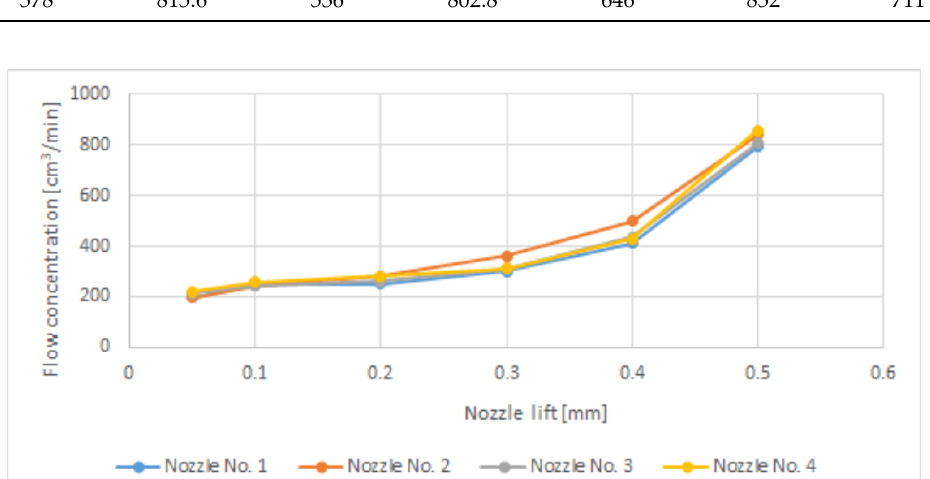
Figure 2. The flow before the test for diesel